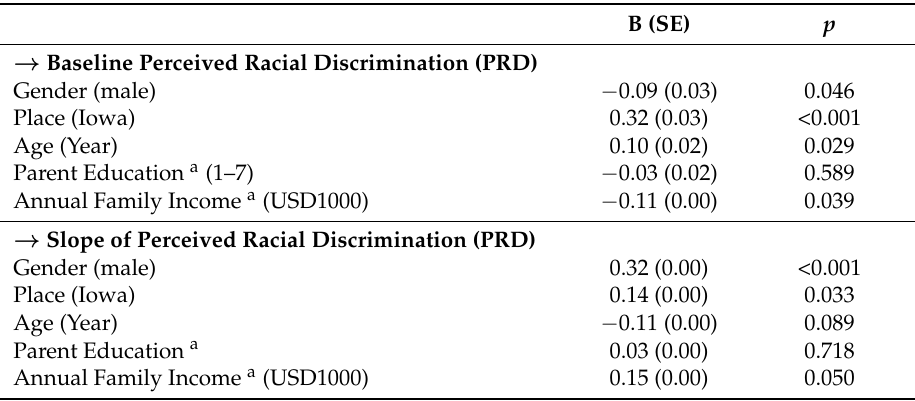
Table 3. Summary of paths in the latent growth curve model on predictors of perceived discrimination over 18 years ( n = 889).